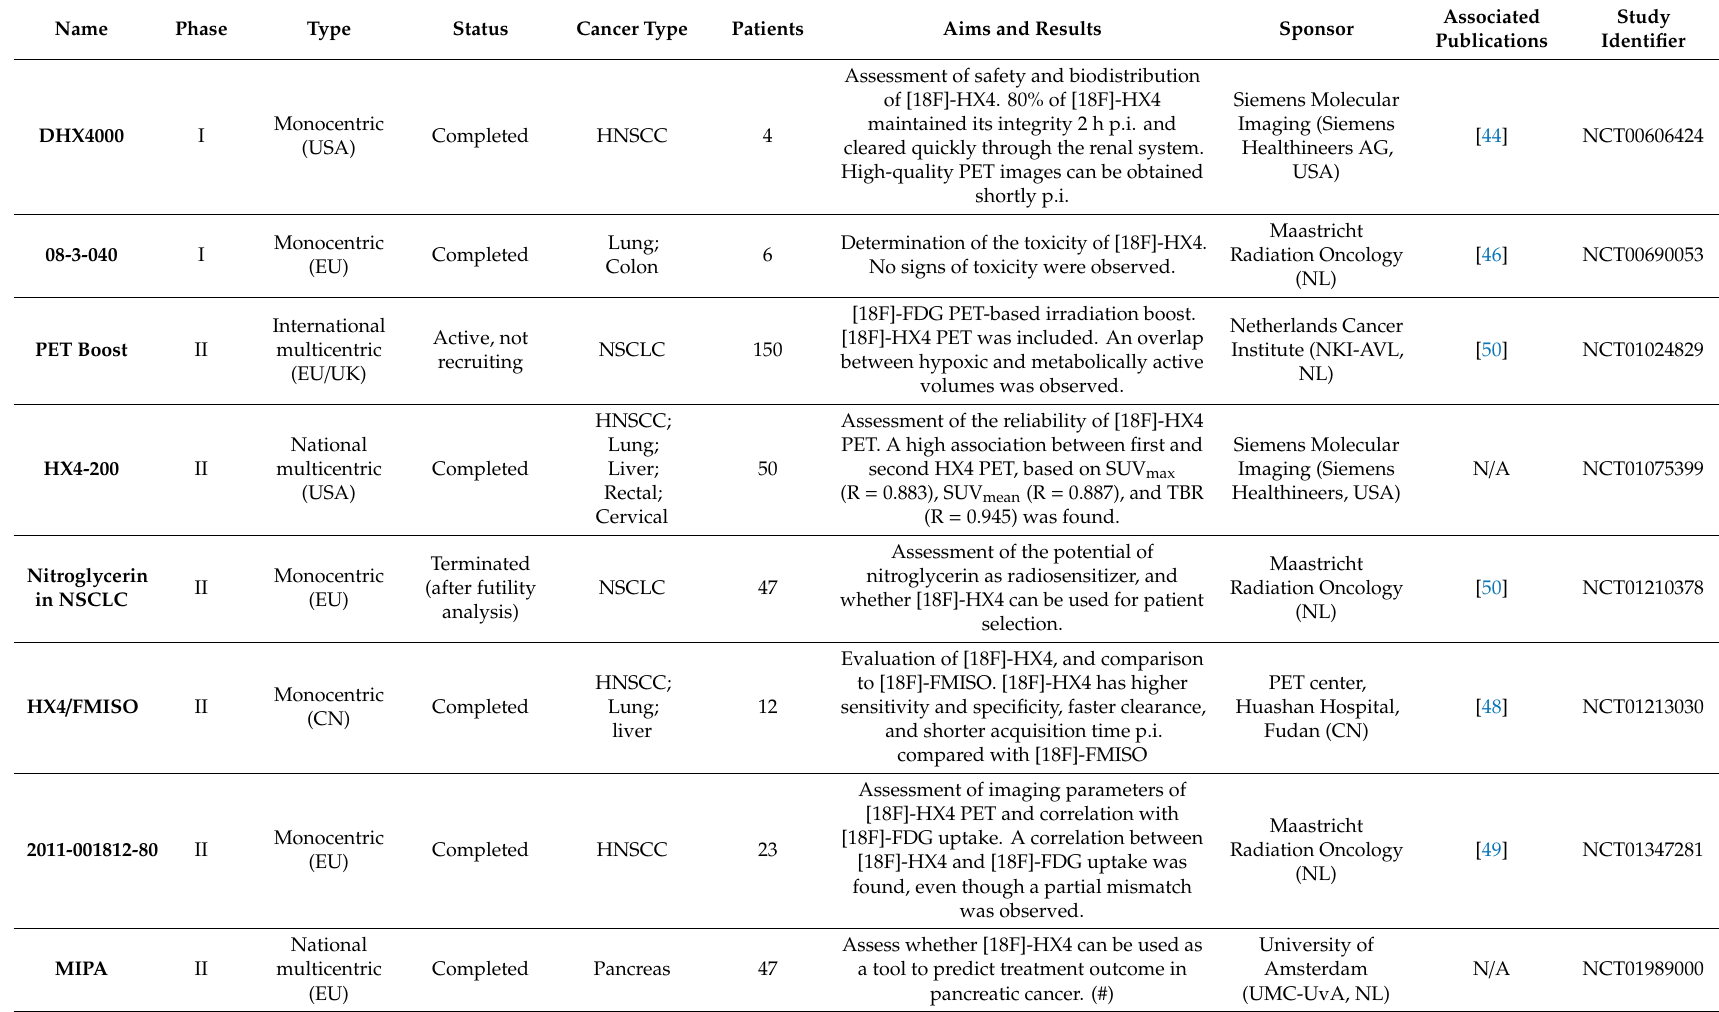
Table 2. Overview of all active, completed, or terminated clinical trials up to date using [18F]-HX4 for the detection of tumor